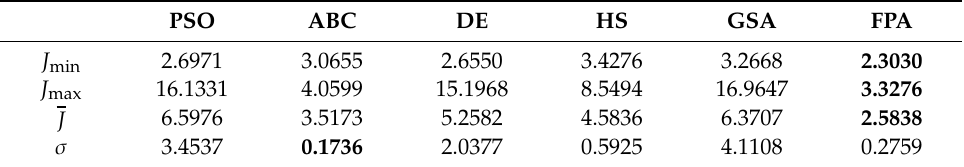
Table 1. Minimum ( J min ) and maximum ( J max ) values of the objective function, mean ( J ) and standard deviation ( σ ) for the results obtained by each algorithm over 250 executions. PSO ABC DE HS GSA